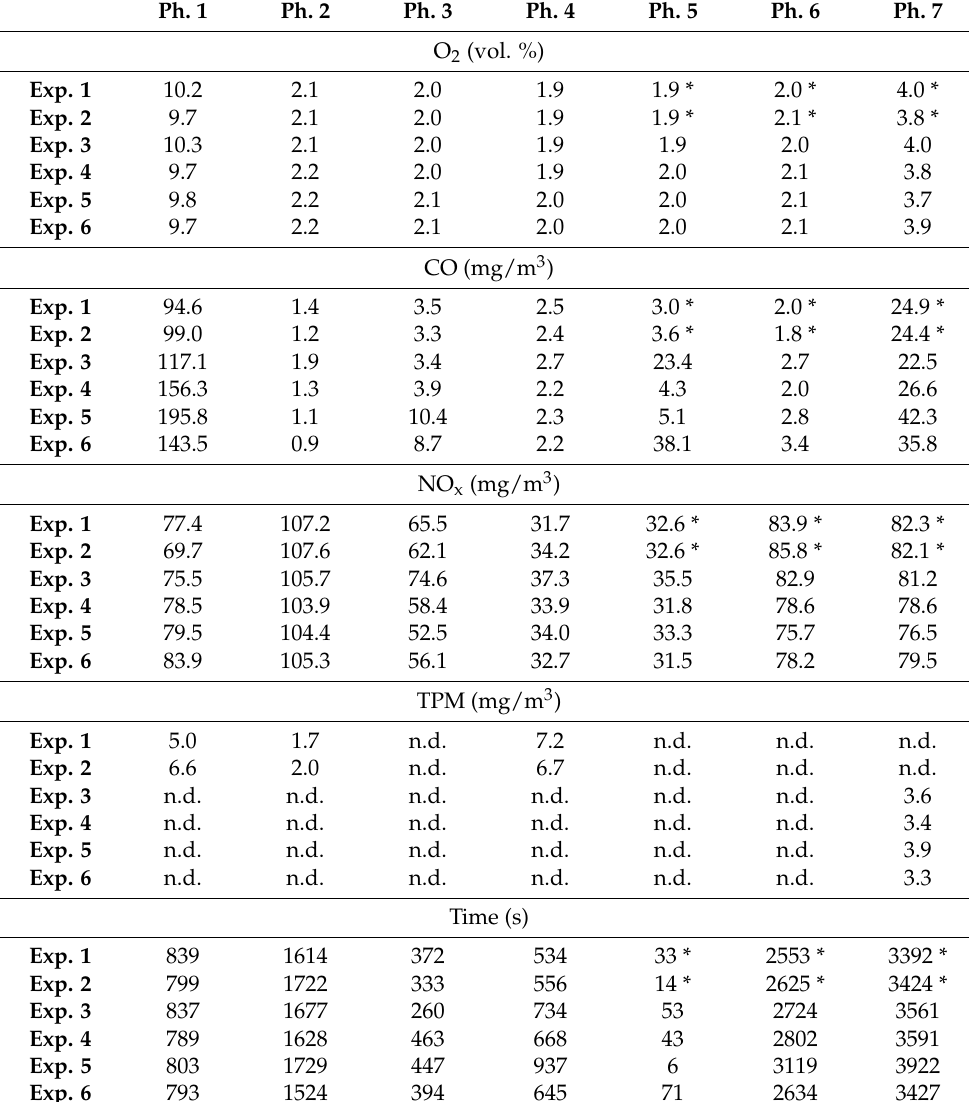
Table 3. O 2 content, emission values (normalized to 13 vol. % O 2 in the dry flue gas (STP)) in the flue gas and duration time for the different phases of the